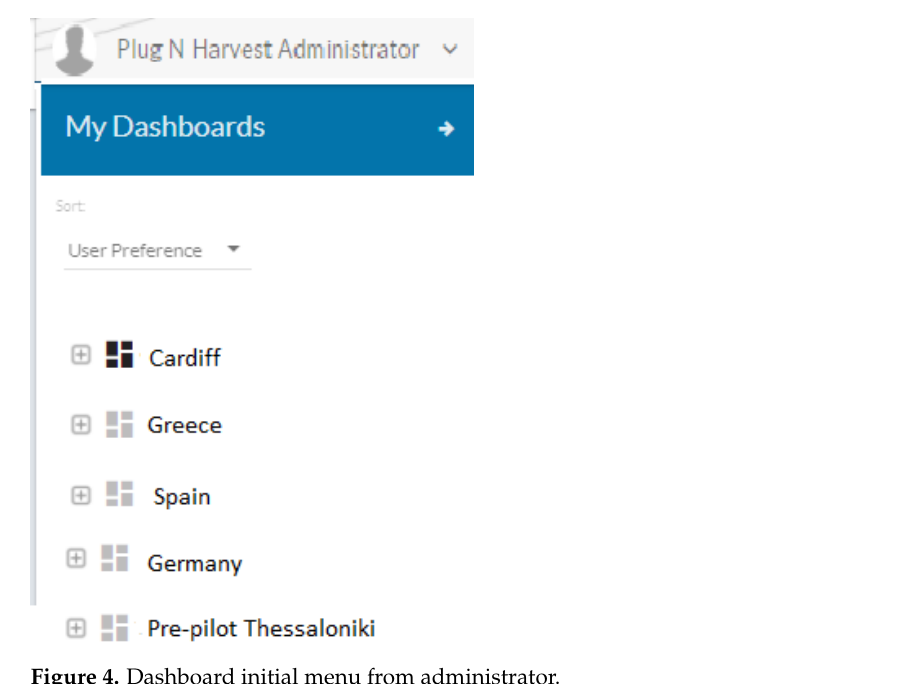
Figure 4. Dashboard initial menu from administrator.